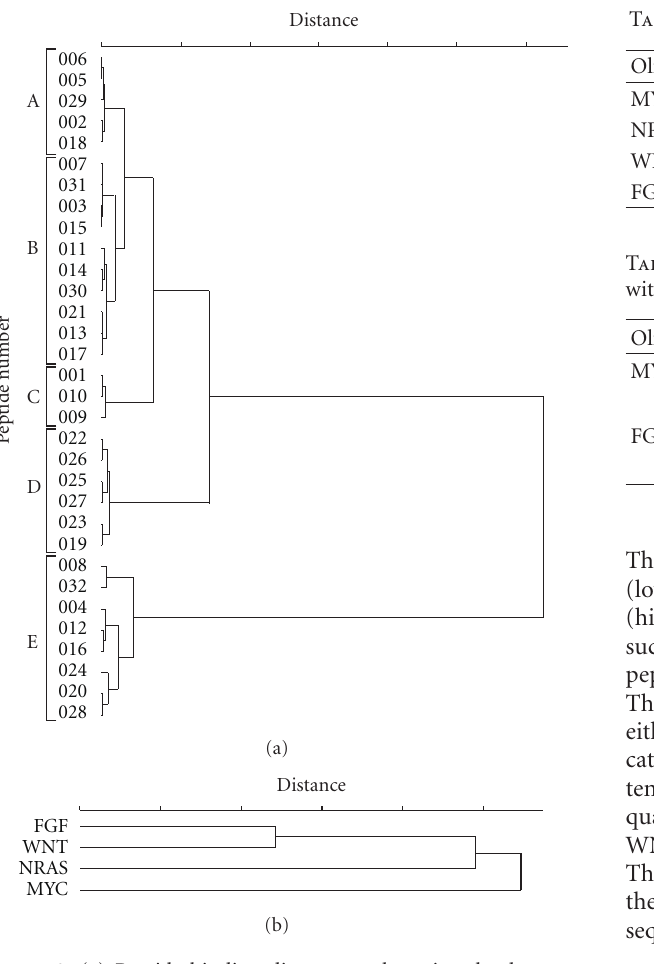
Figure 3: (a) Peptide-binding divergence clustering dendrogram generated by Euclidean distance analysis. (b) DNA-binding prop- erty clustering dendrogram generated by Euclidean distance analy- sis.